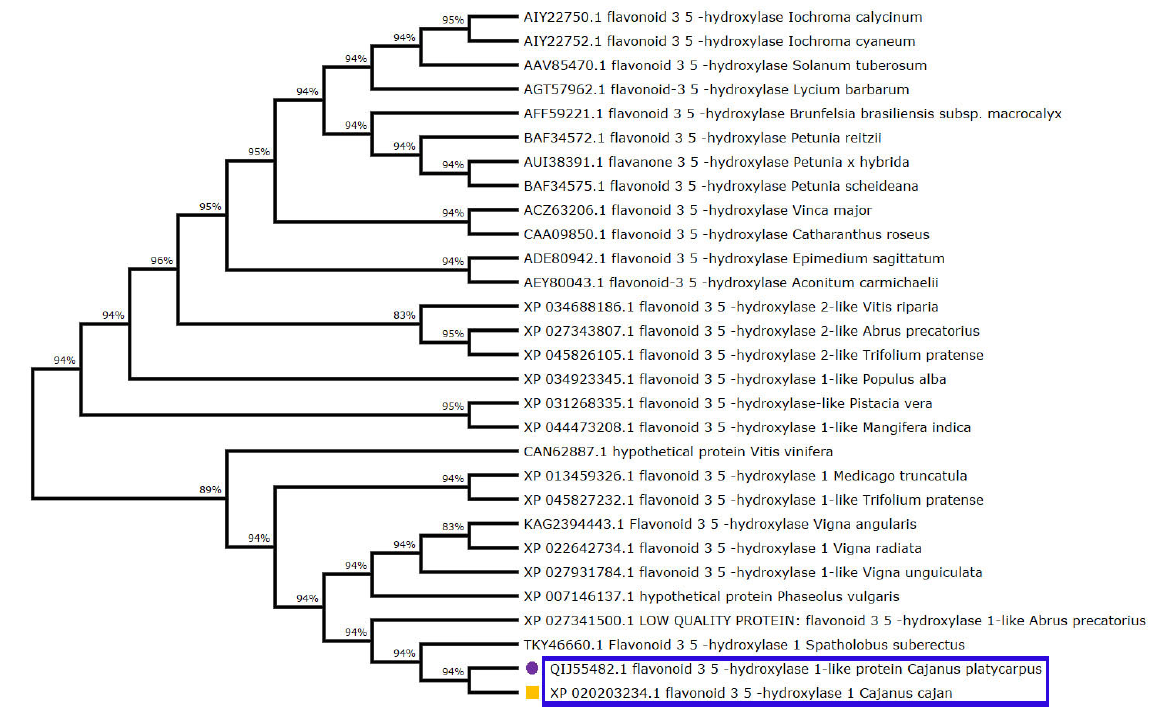
Figure 3. Phylogenetic tree analysis exhibiting relationship between F3 ′ 5 ′ H_2 from both the Cajanus spp. and other closely related plant species. Percentage of bootstrap values was displayed at each node, whereas branches of C. cajan and C. platycarpus were highlighted with yellow coloured square and purple coloured circle shapes, respectively.